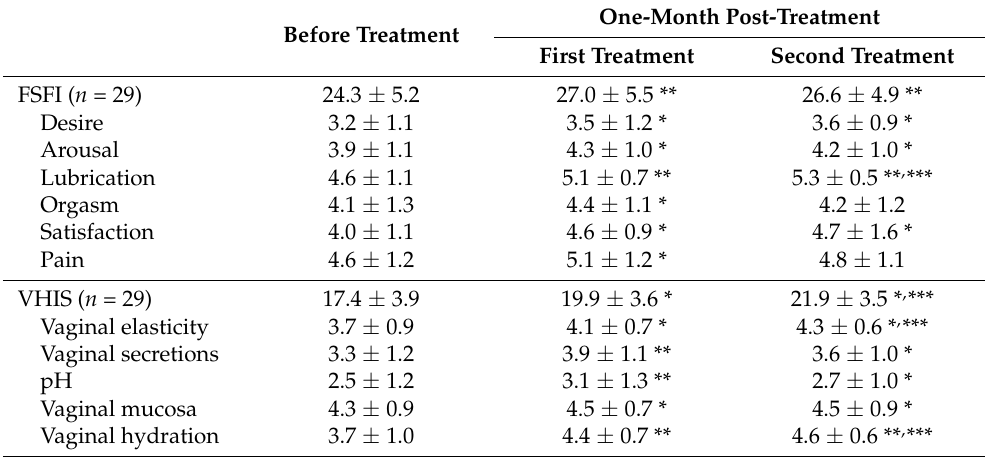
Table 2. Total and Domain-Specific Scores of FSFI and VHIS in patients Before and After Each Laser Treatment Session. Before